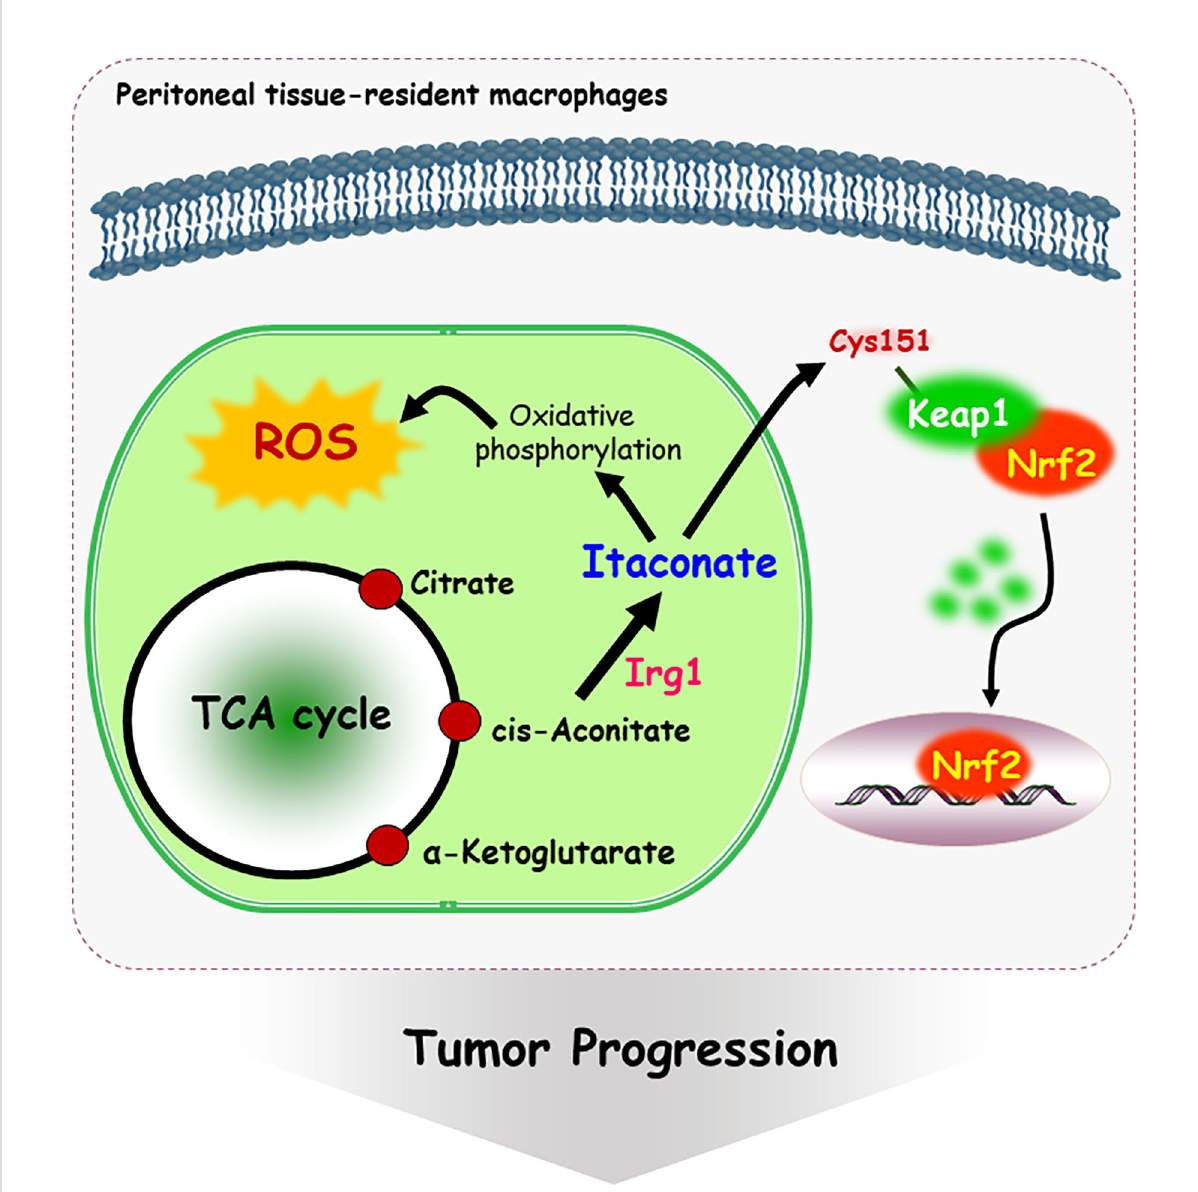
FIGURE 3 Mechanism of itaconate-mediated cysteine modi fi cation. Immune-responsive gene 1 (Irg1) is a mitochondrial enzyme-producing